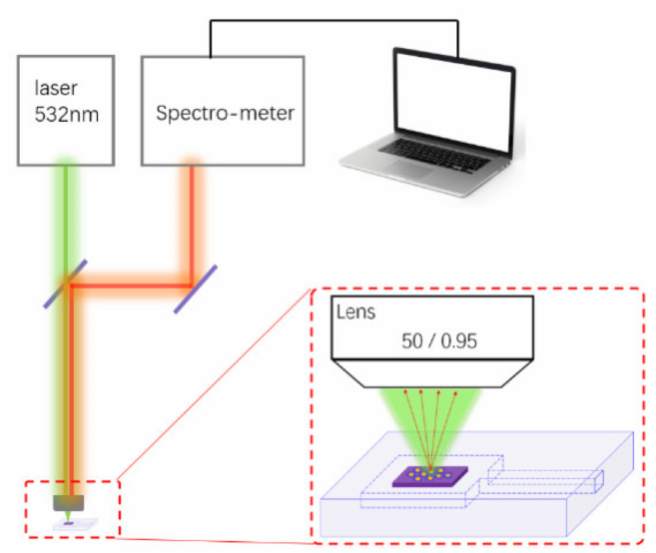
Figure 4. Schematic diagram of ethanol sensor with a SERS chip Raman spectrometer